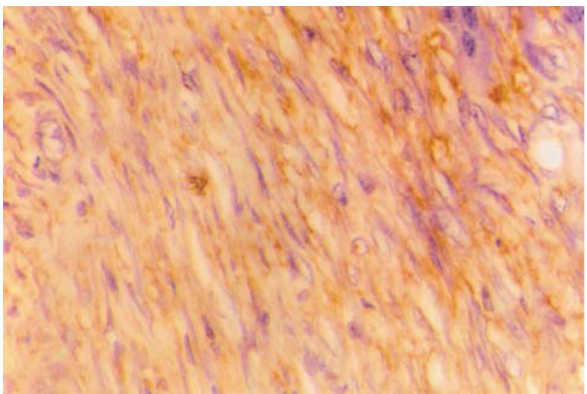
FIGURE 4 - Fibronectin immunoreactivity in giant cell tumor of long bones. Reticulate/fibrillar organization pattern and positive staining around the basement membrane of blood vessels (arrow) (SABC – 100x)